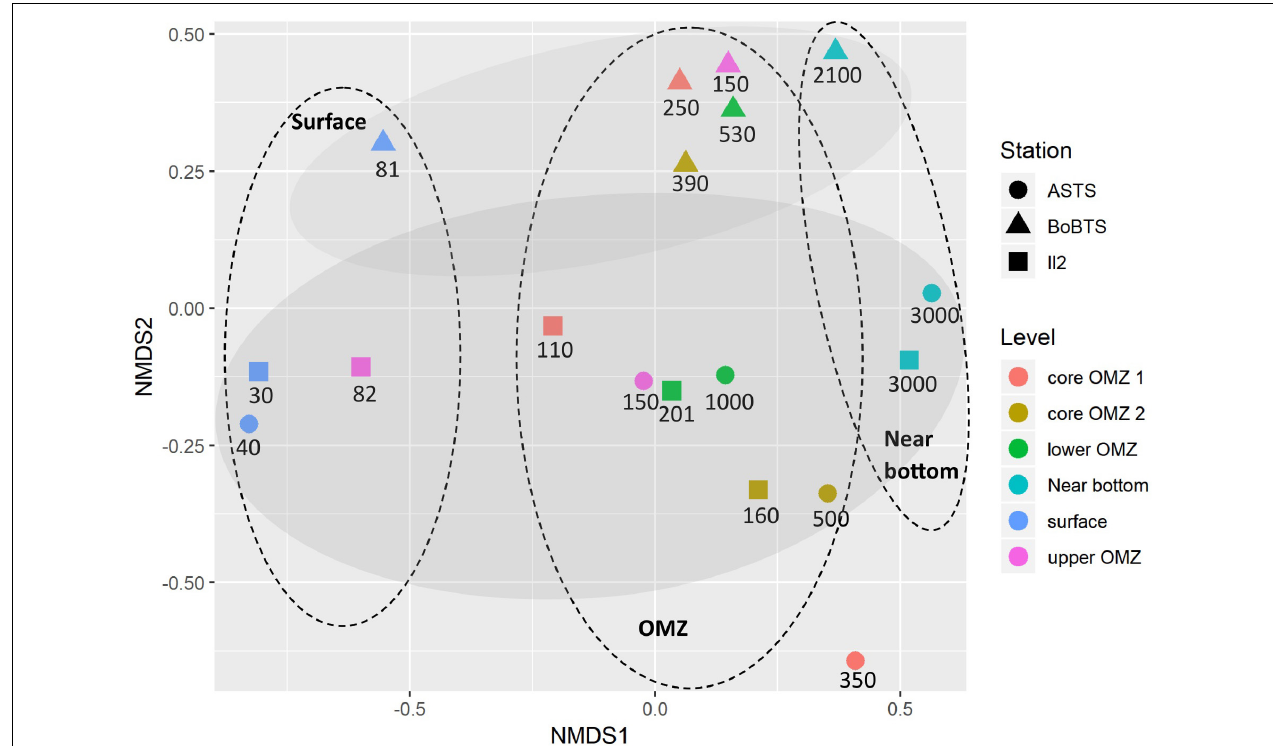
FIGURE 4 | Non-metric multidimensional scaling (NMDS) plot depicting class-level bacterial composition from six depths of ASTS, BoBTS, and II2. Axis define 2D space that allows the best spatial representation of sample distance, based on Bray–Curtis distance with stress = 0.08. The depths in meters of each sample are mentioned below the respective symbol, while the oval dashes represent the three planes which divides the data based on vertical depth profile and the shaded oval regions represent grouping of data based on location.